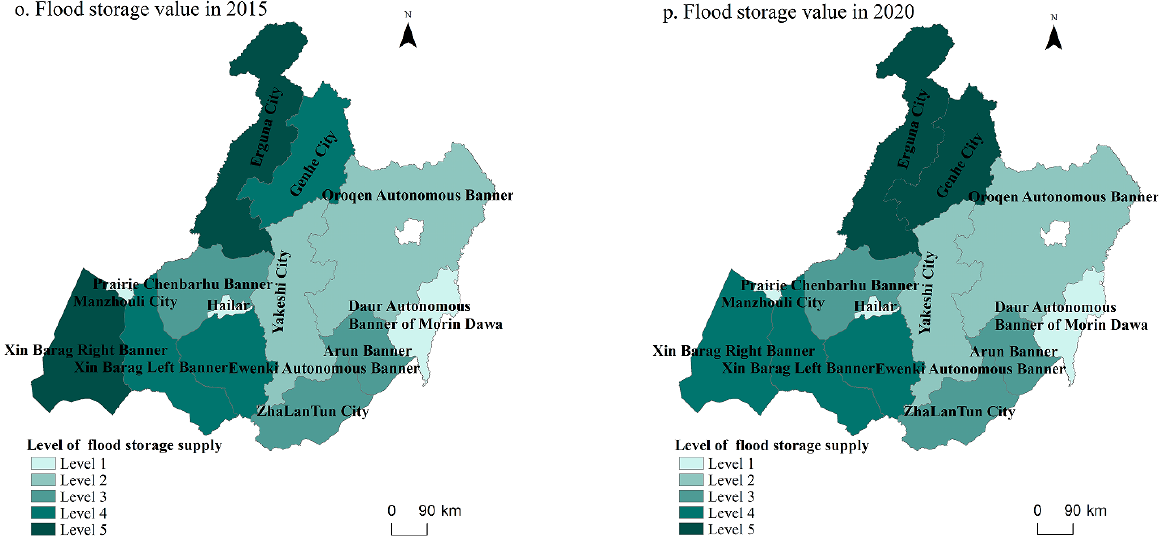
Figure 2. Spatial distribution map of eight regulatory function grades.